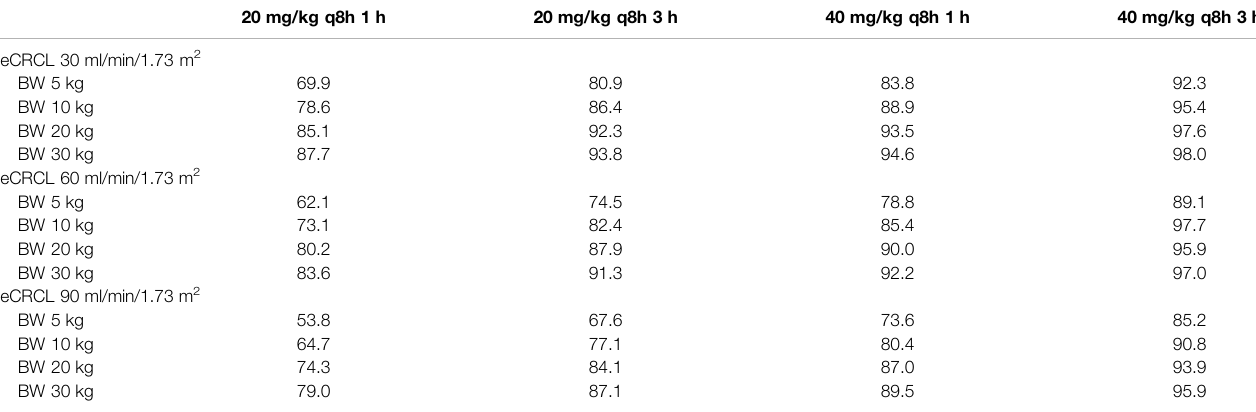
Notes: Percentages indicate the PTA for different infusion durations of meropenem at the dose of 20 mg/kg or 40 mg/kg every 8 h. MIC of 2 mg/L has been used as reference, corresponding to the EUCAST breakpoint for Enterobacteriaceae and P. aeruginosa .